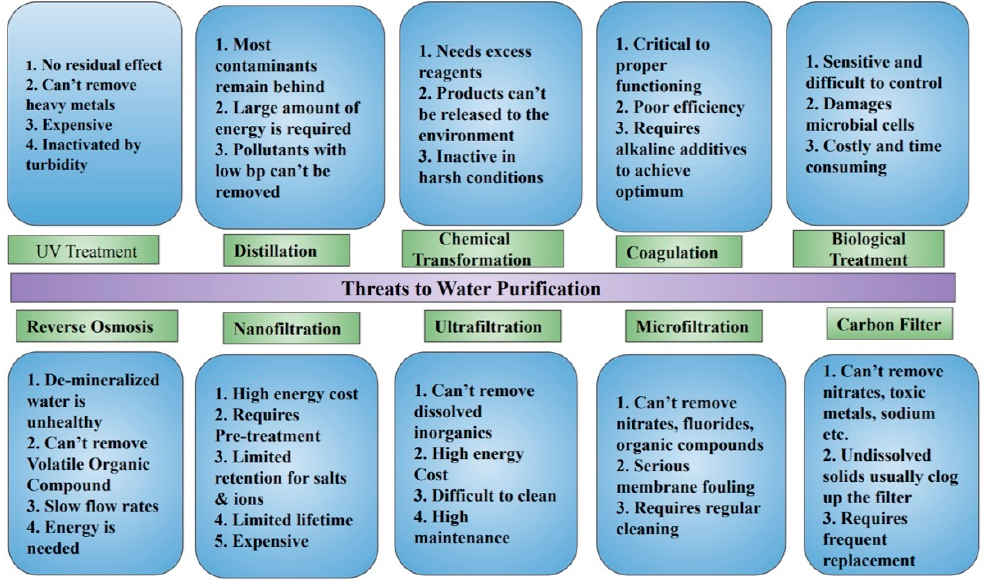
Figure 2. Major shortcomings of conventional purification systems (Reproduced with permission from Elsevier; adapted from Das et al, 2014 [23]).